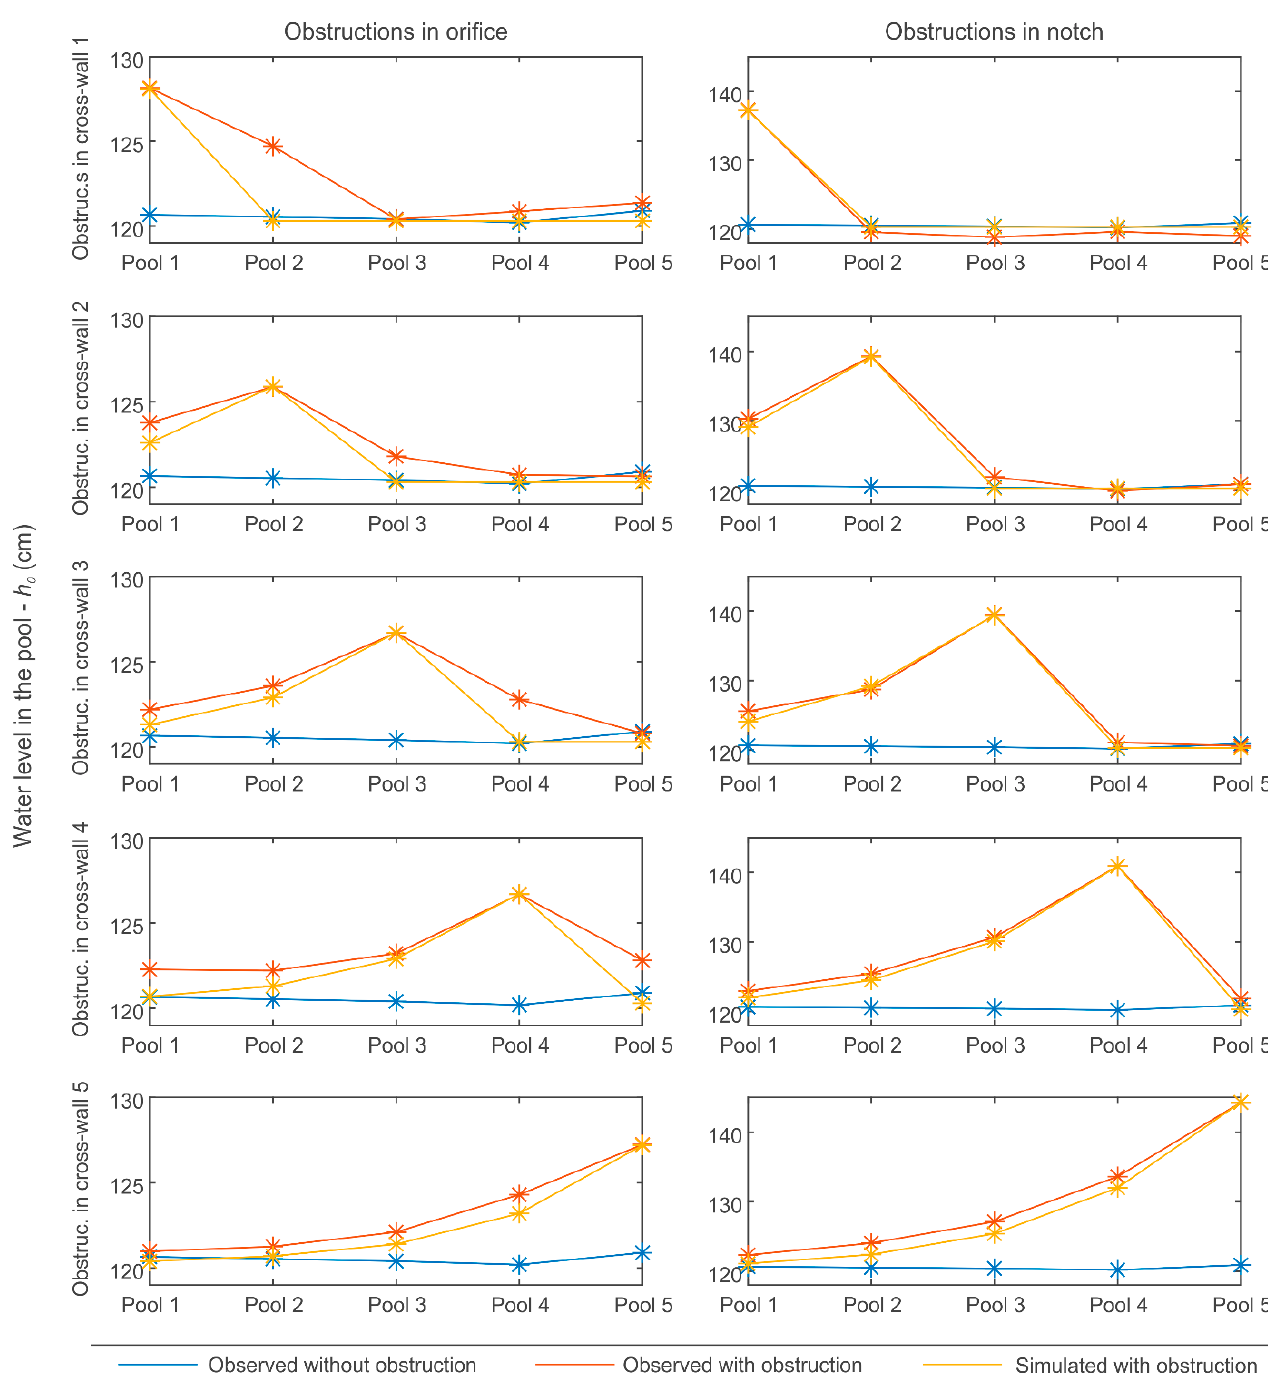
Figure 5. Scenarios tested in the field against 1D simulations of tested setups.